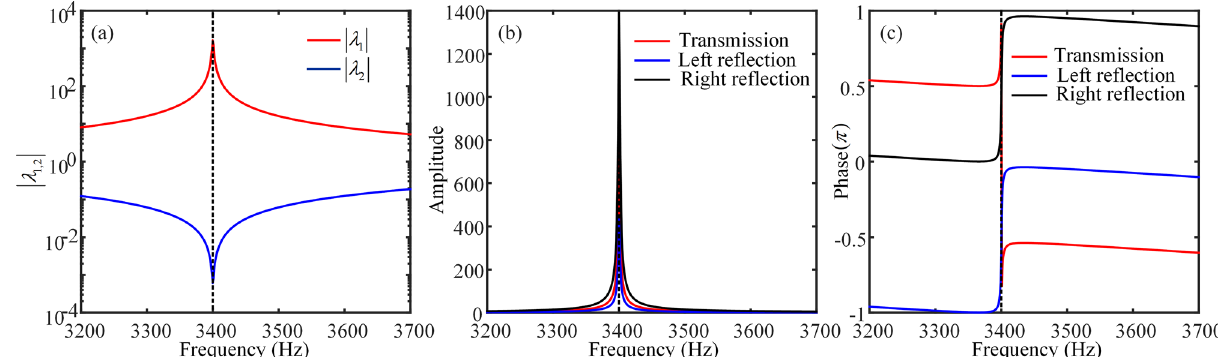
Figure 3. Scattering properties of the locally PT -symmetric metasurface. ( a ) The absolute values of two eigenvalues as functions of frequency. ( b , c ) The amplitude and phase of the transmission, left-reflection and right-reflection coefficients for the PT -symmetric metasurface as functions of frequency, respectively. The vertical dotted lines in ( a ), ( b ) and ( c ) indicate the frequencies of f = 3,400